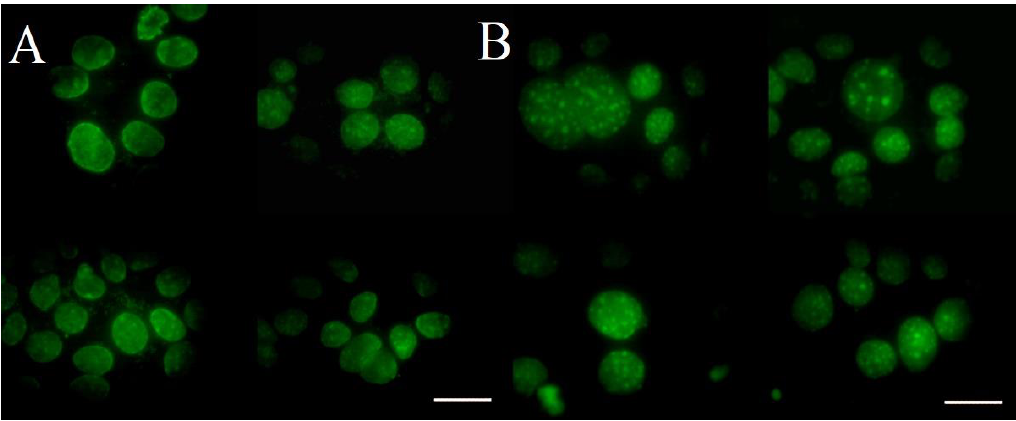
Figure 8. Nucleus of SCC cells stained by DAPI. ( A ) DMSO control, ( B ) treated with 17.0 µ M of compound 10 .